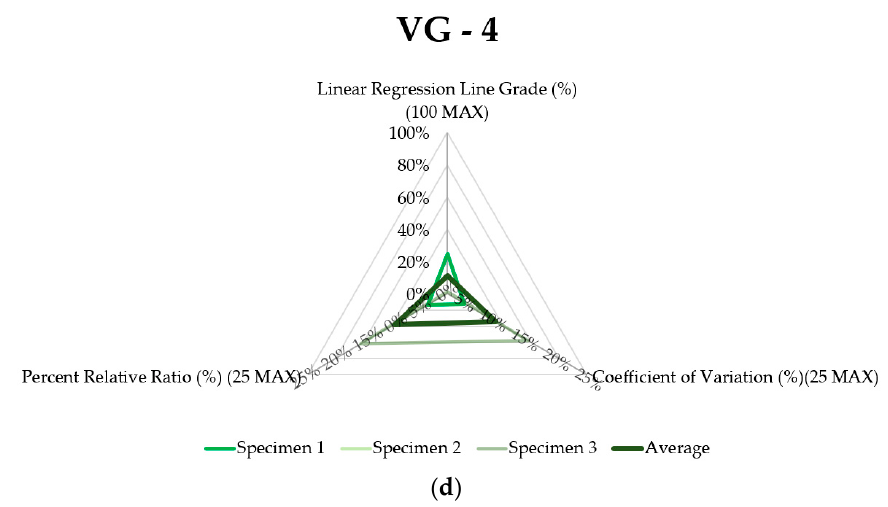
Figure 13. An adhesion stability evaluation of 4 types of NHV-SPRG; ( a ) VG 1, ( b ) VG 2, ( c ) VG 3, ( d ) VG 4.